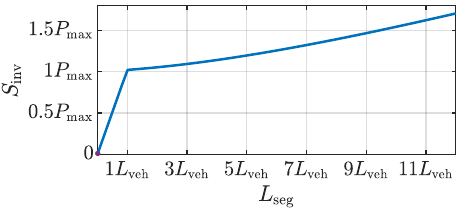
Figure 9. Inverter power in relation to L seg in the multi-inverter